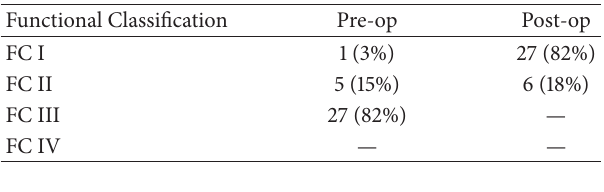
Table 1: NYHA Functional Classification.